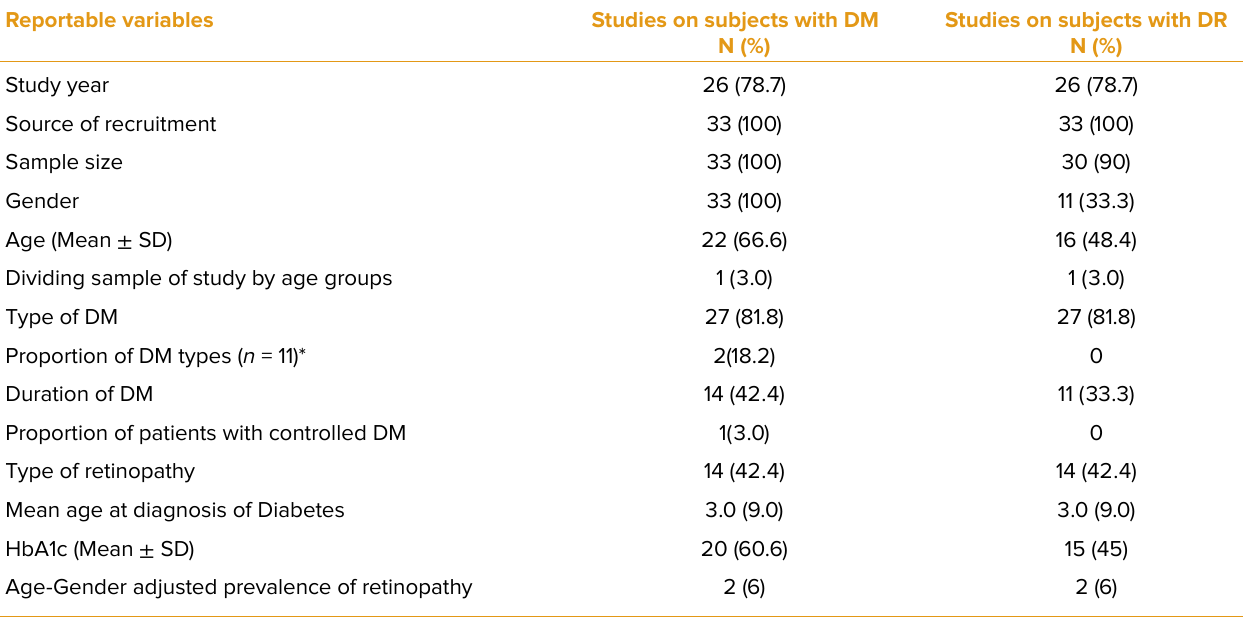
Table 2. Number (%) of studies reporting important criteria required in epidemiological studies on diabetic retinopathy